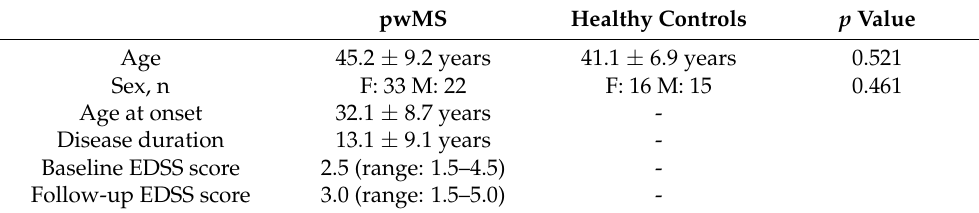
Table 1. Demographic and clinical features of people with multiple sclerosis and healthy controls.